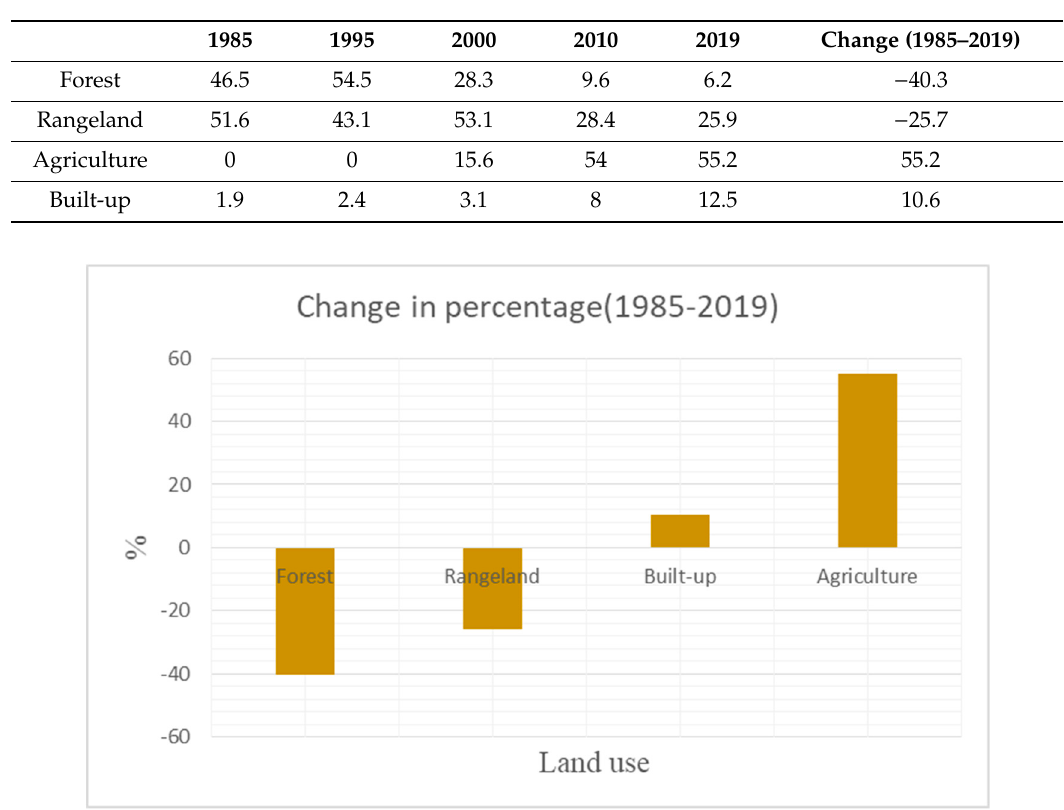
Table 6. Percentage of land use/cover in Kakia and Esamburmbur sub-catchments of Enkale Narok watershed between 1985 and 2019.